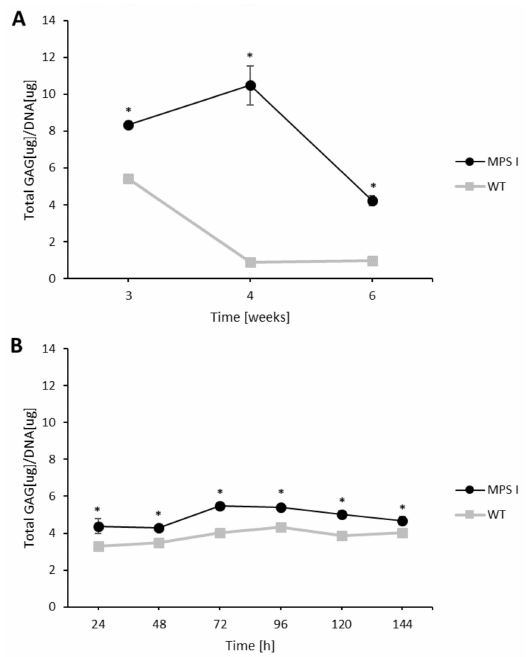
Figure 4. Total GAG content in mucopolysaccharidosis I (MPS I, black circles) and wild type (WT, grey squares) murine fibroblasts ( A ) and primary hepatocytes ( B ) during cell culturing. Results are presented as the mean ± SD obtained for three different cell cultures for two different experiments in each case. An asterisk (*) indicates statistically significant differences between MPS I and WT cells (two-tailed t -test, p <